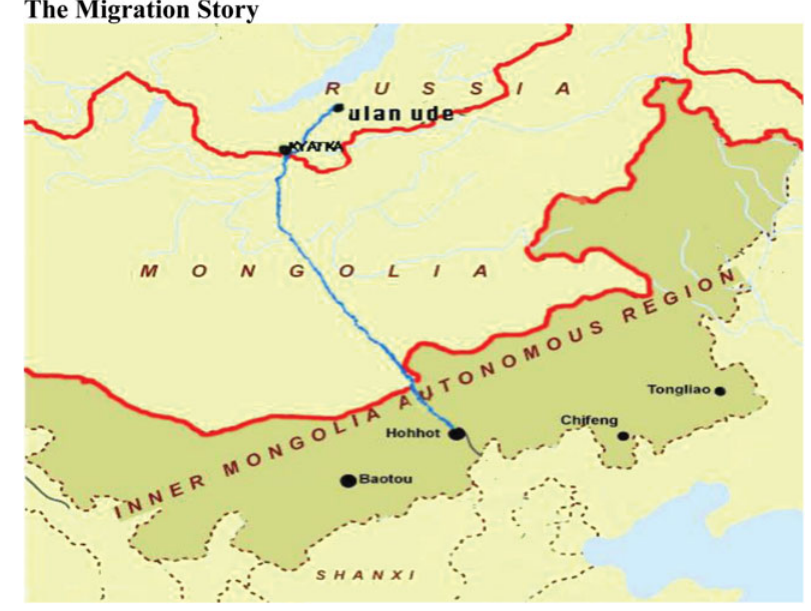
(Colour online) Migration route from Buriatia, Russian Federation to Inner Mongolia,